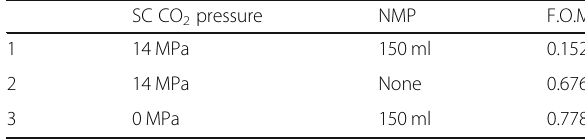
Table 1 A summary of the exfoliation figure of merits